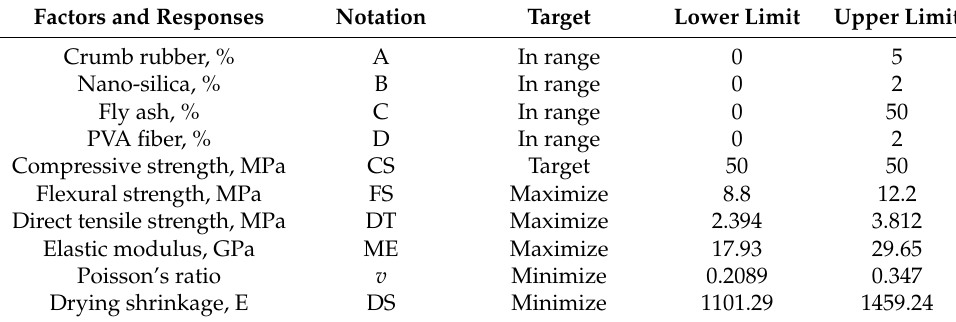
Table 8. Criteria for multi-objective